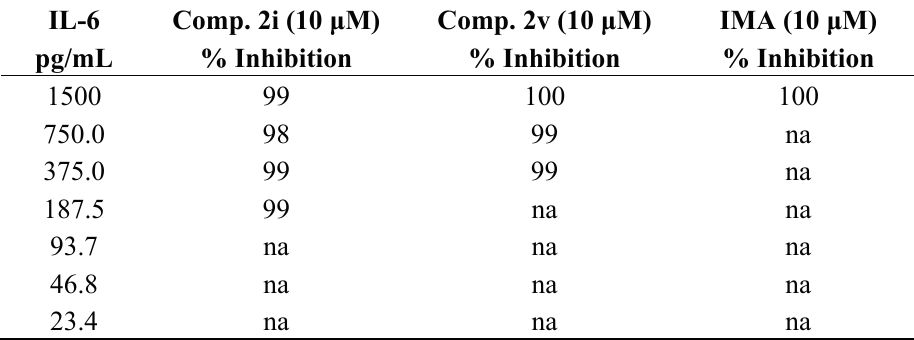
Table 8. Percent inhibition of interleukin-6